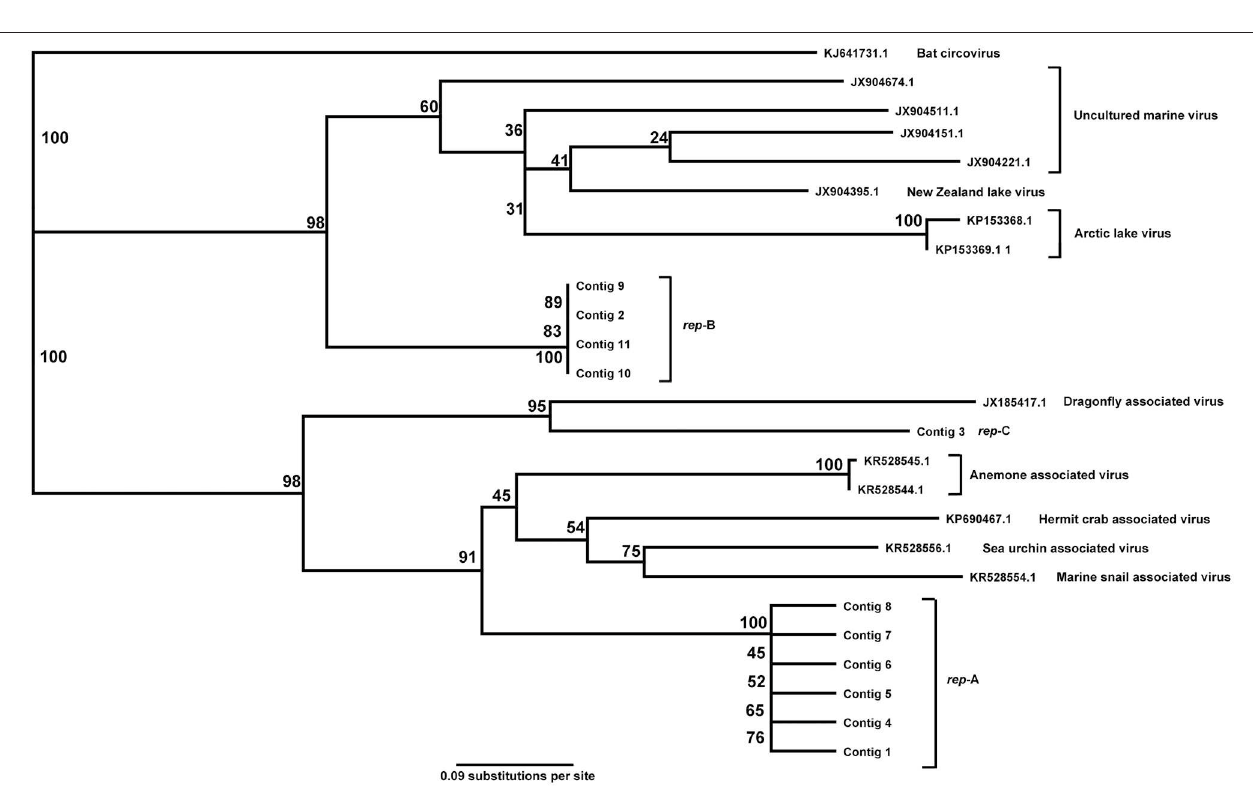
FIGURE 4 | Alignment tree of rep ORFs in circovirus-like